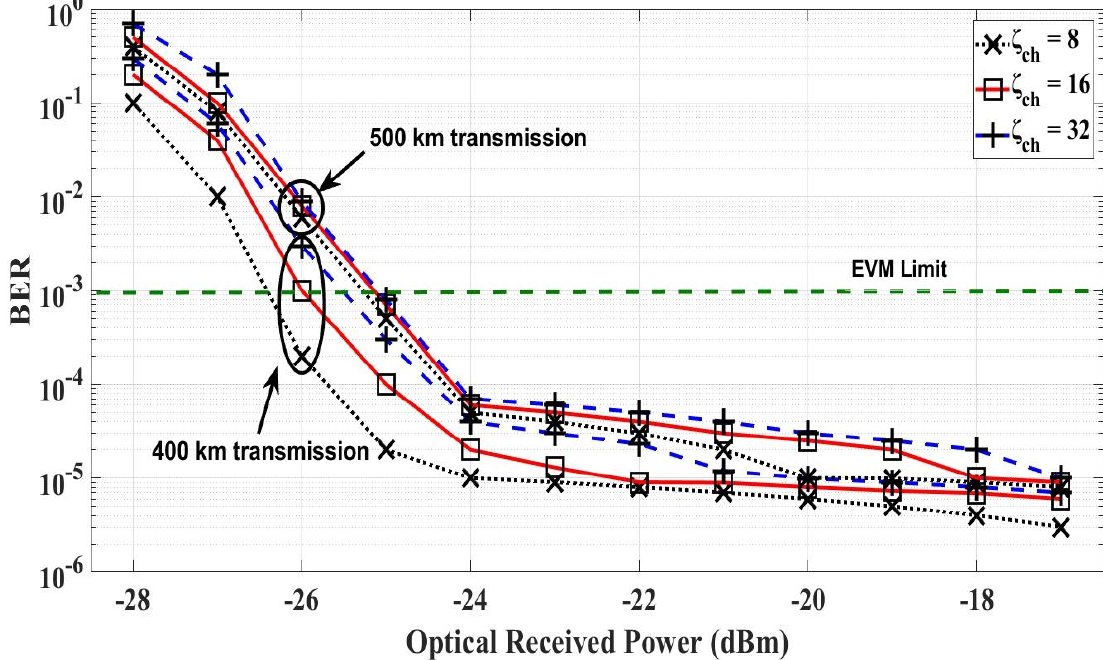
Figure 14. Receiver sensitivity for 8, 16 and 32 channels after 400 and 500 km of optical fiber